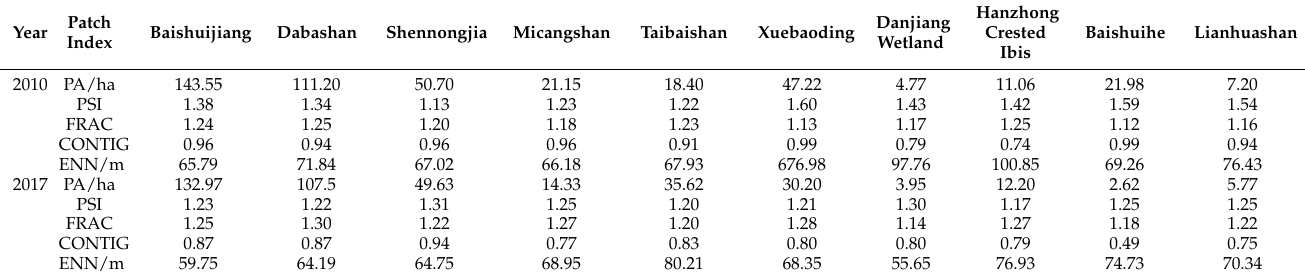
Table 3. Landscape type index of each nature reserve in the Qinling–Daba